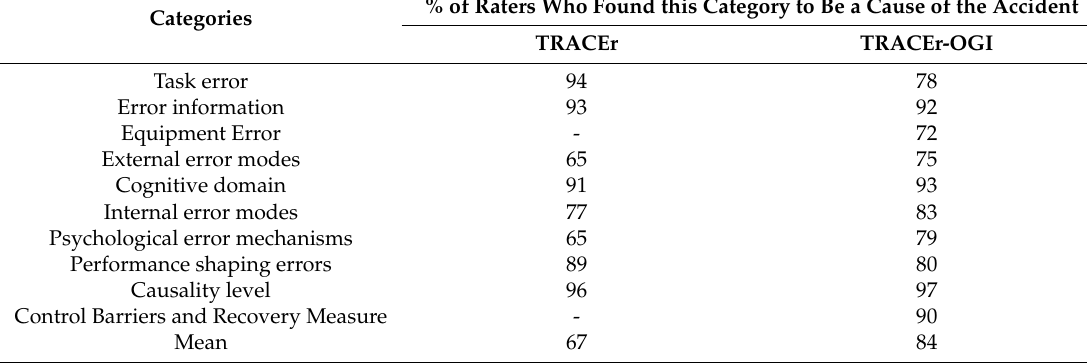
Table 9. Average percentage agreement from all participants using TRACEr and TRACEr-OGI.